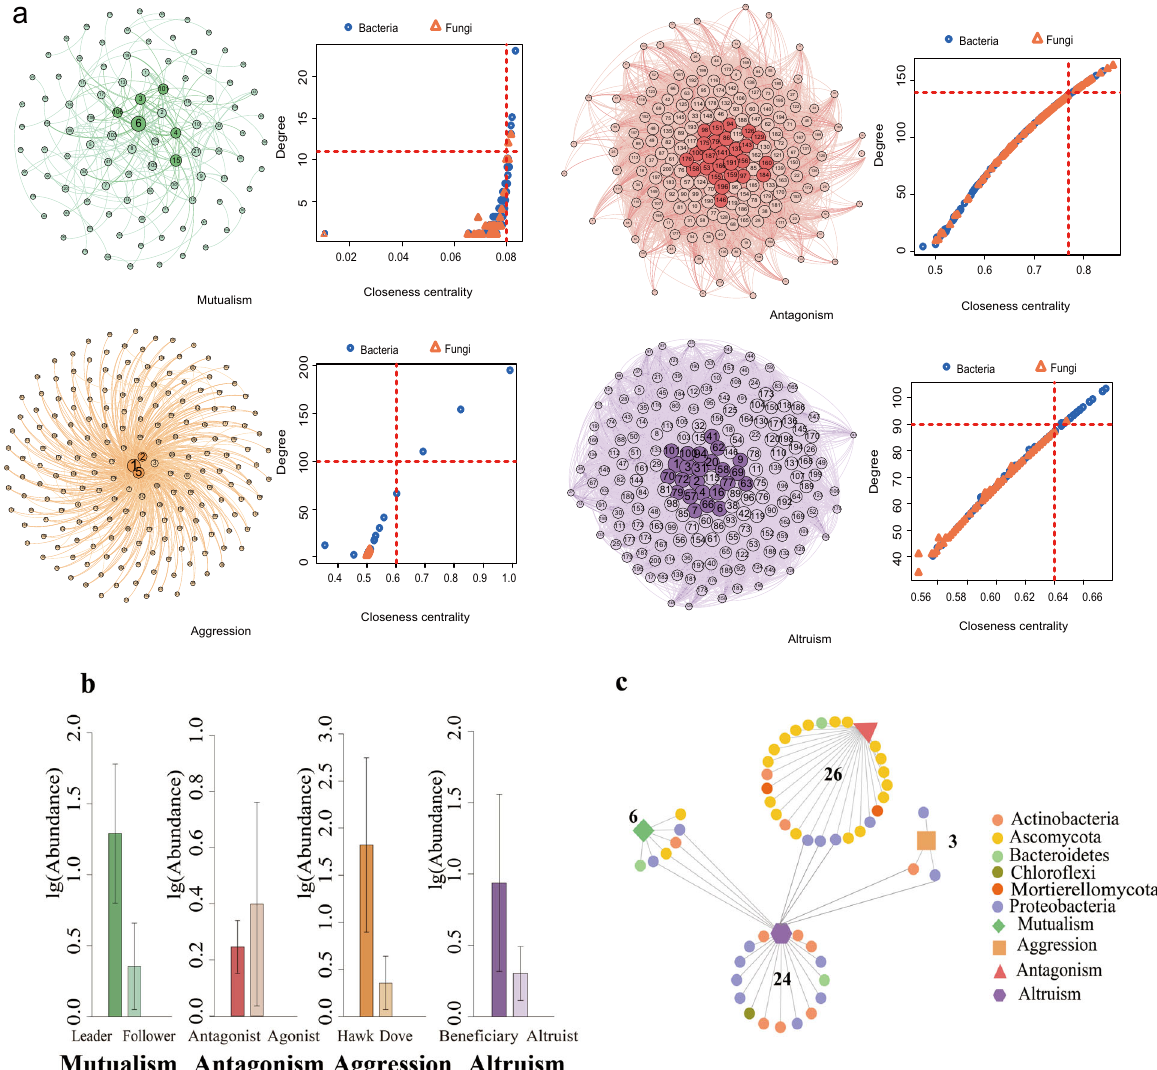
Fig. 2 Hubs of the co-occurrence network. a The identity of each OTU is labeled by a number, one to 100 for bacteria and 101 to 200 for fungi. In each network, hub microbes are highlighted in border colors. The distribution of ‘ Hub microbes ’ in four different microbial networks was based on degree and closeness centrality values. These two values of each OTU within each network were given at the right. The red dotted line represents the screening cutoffs of ‘ Hub microbes ’ corresponding to each network. b The abundance of hub microbes within each network. c The shared hub microbes within each microbial network. This ‘ shared network ’ was represented in Cytoscape. Circle shapes represented hub microbes from each microbial network and irregular shapes represented different microbial network types. The edges were connected to hub microbes and microbial network. Visualization was done with Gephi for four microbial